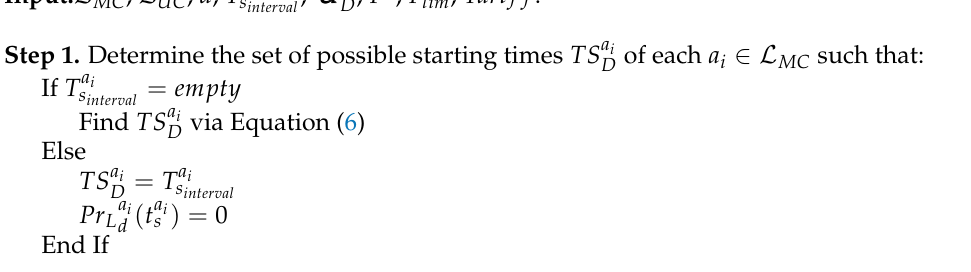
Algorithm 1 AS-REMS